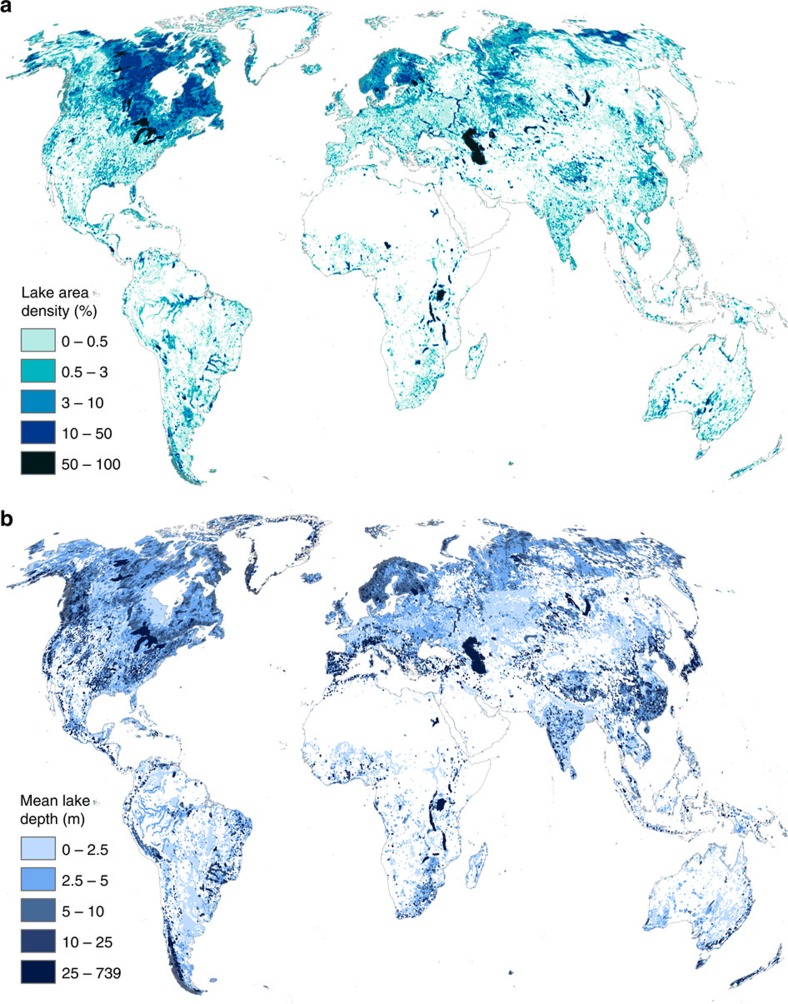
Patterns of global lake distribution.(a) Lake area density (limnicity) calculated as percent area covered by lakes within a 25 km radius. (b) Average depth of all lakes within a 25 km radius, weighted by their partial area within that radius. Both maps include reservoirs from the Global Reservoir and Dam (GRanD) database28.